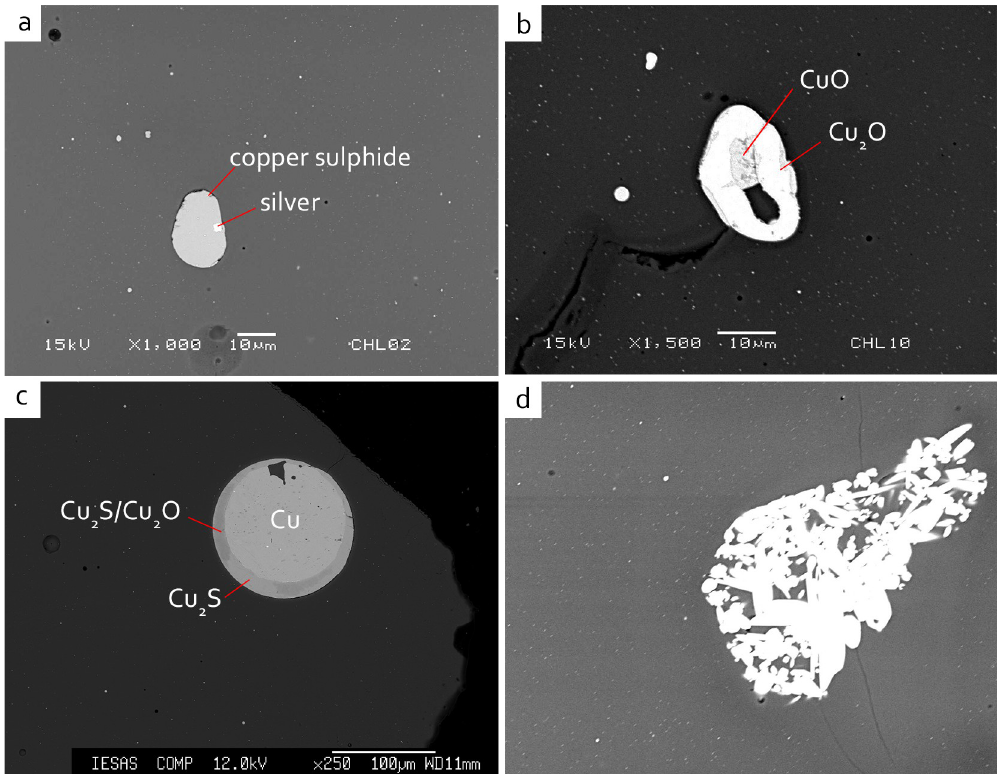
partial oxidation (GS004), and (d) a cluster of needle-like tin oxide remain the crude cassiterite shape